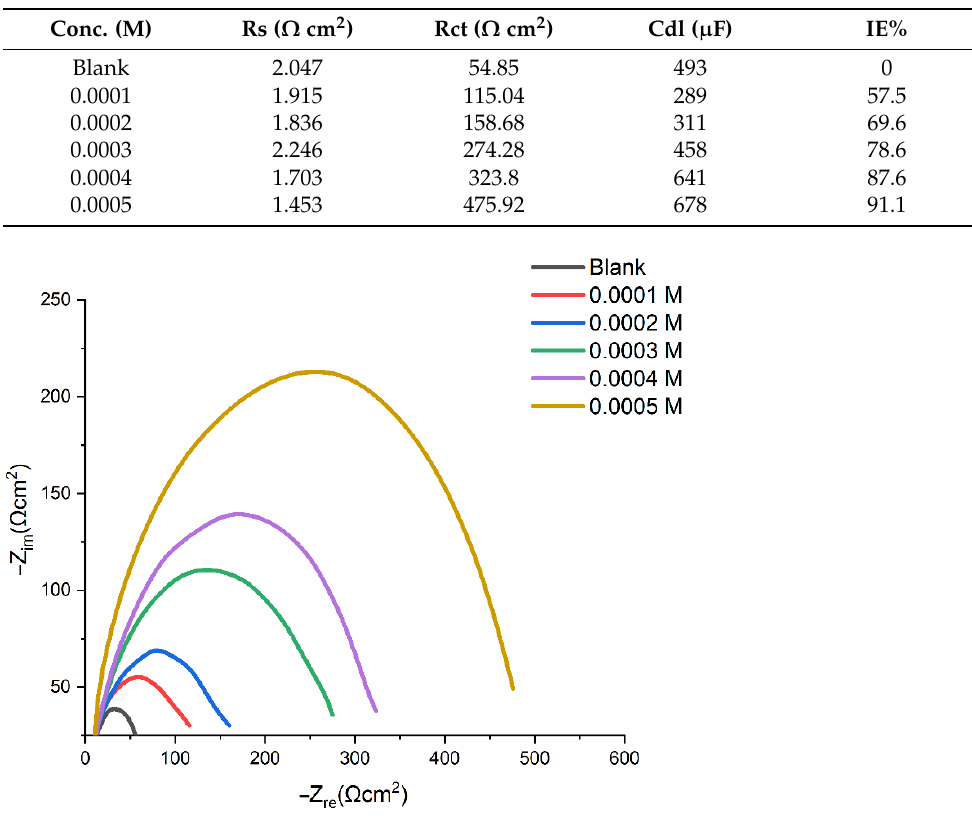
Figure 8. Nyquist plots of mild steel in 1 M HCl without and with the addition of various concen- trations of PMBMH. tions of